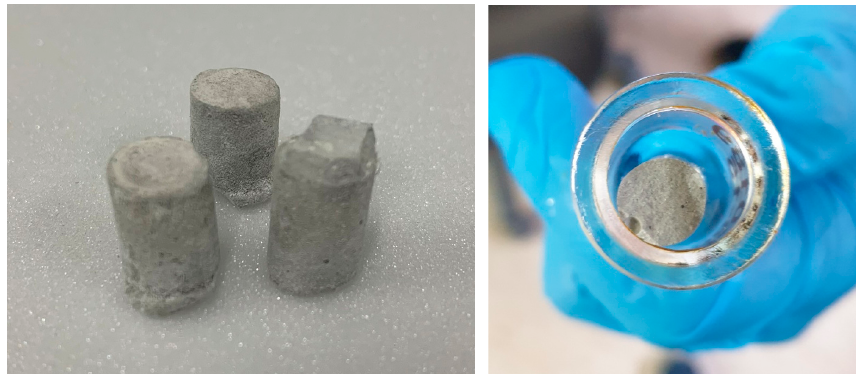
Figure 3. Bonding strength test.